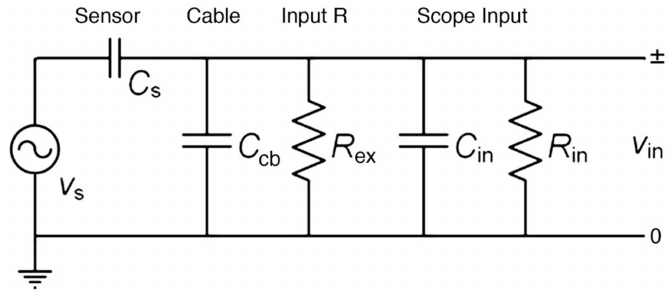
Figure 6. Equivalent circuit diagram of oscilloscope input. See text for symbols used.